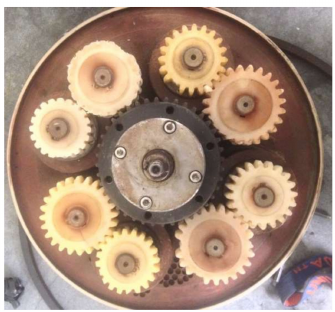
Figure 24. Spur gear failure in a ball-milling